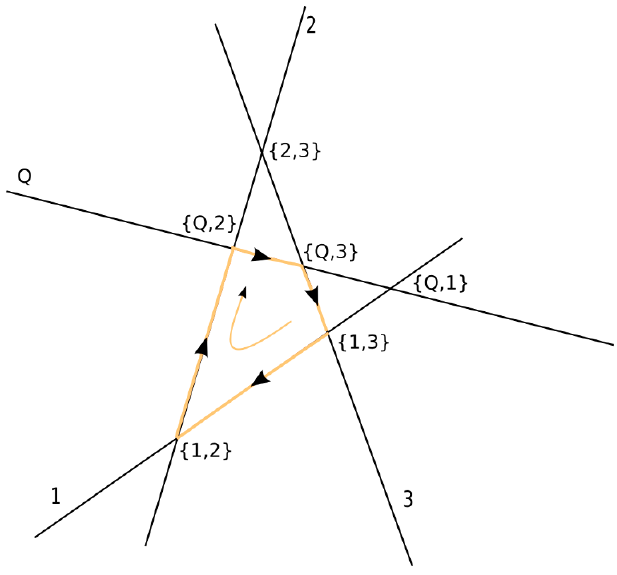
Figure 9 . The area de(cid:12)ned by the vertex object F 12 .